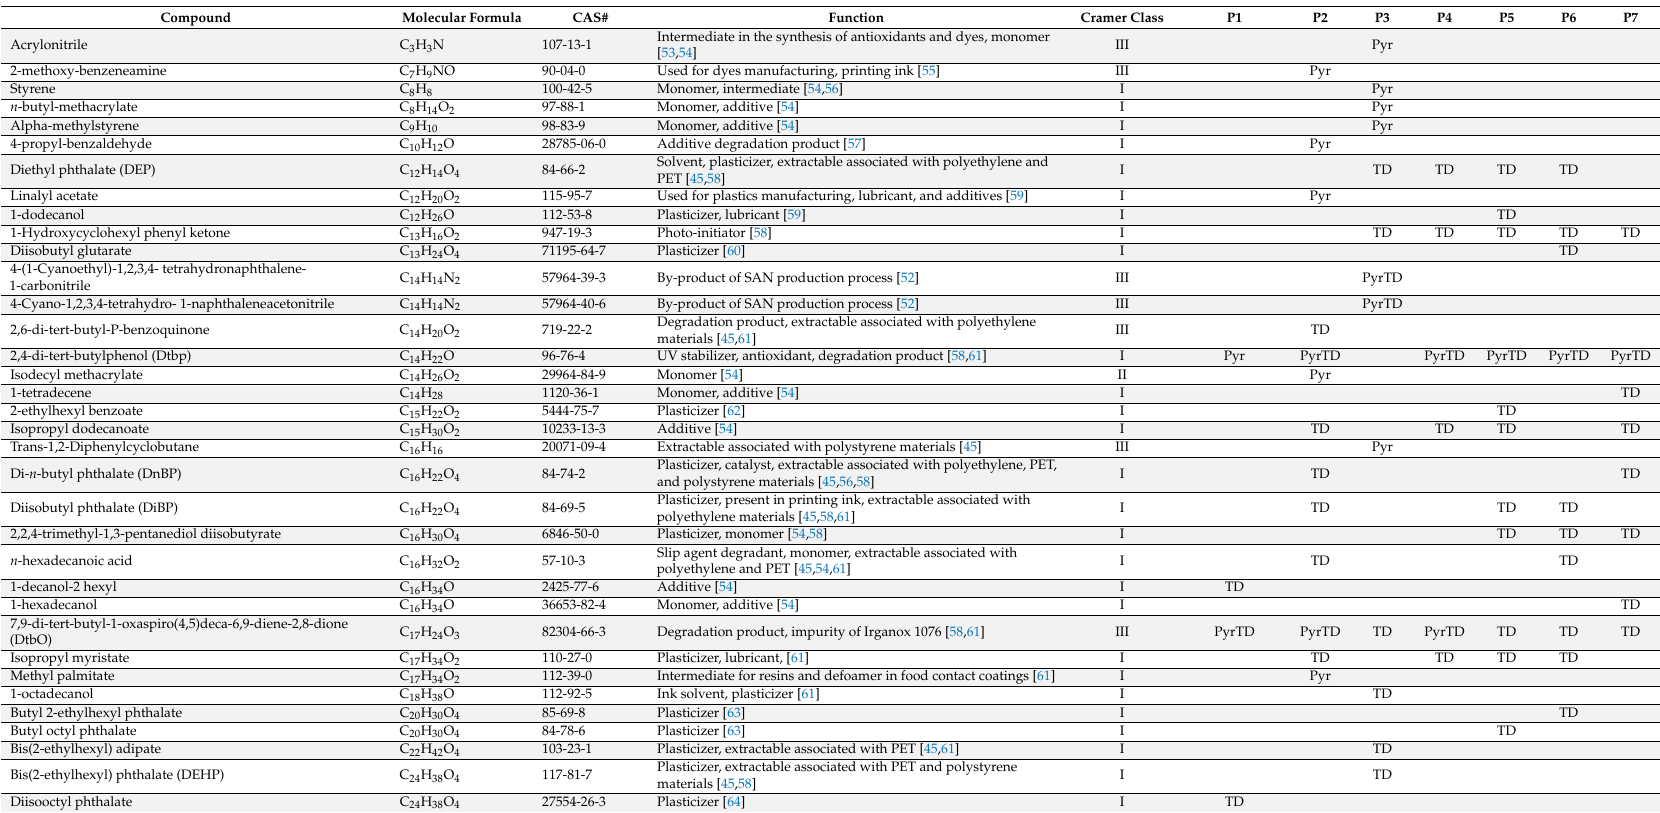
Table 1. NIST ® identification of compounds extracted by Pyr and µ